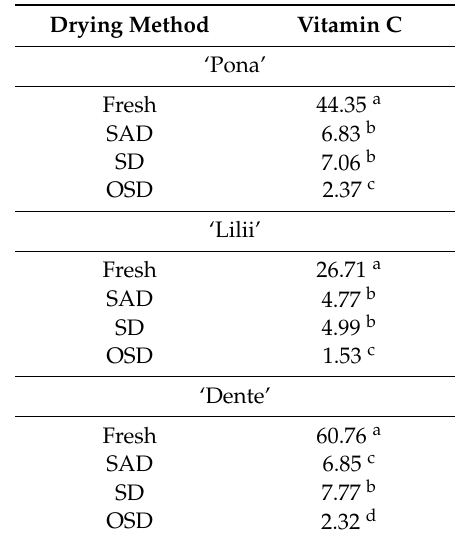
Table 3. Vitamin C content (mg / g dry matter) of fresh and dried cultivars of yam at di ff erent drying methods.